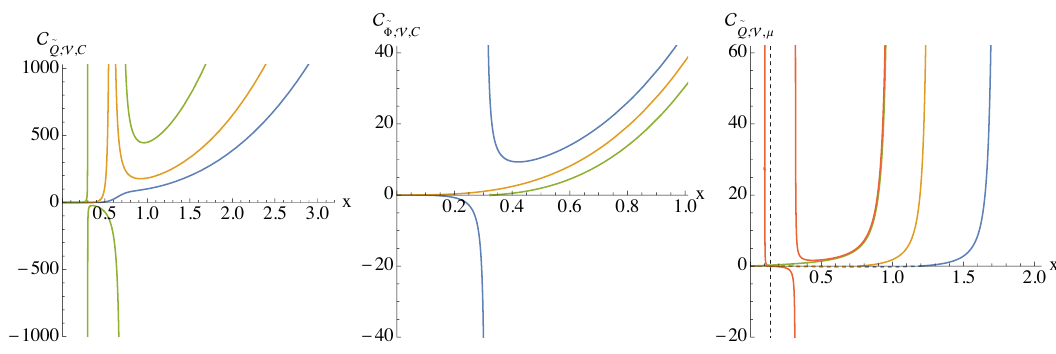
(˜Φ ˜ ˜ Q, V , C ) , , V , C ) and ( Q, V , µ ) ensembles